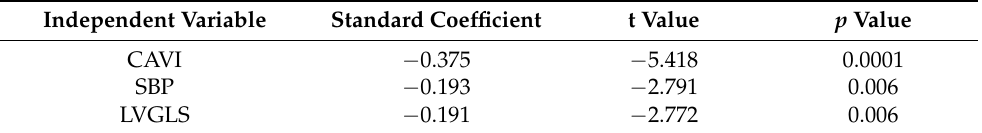
Table 3. Multiple regression documenting the association of LA conduit strain with clinical variables. Independent Variable Standard Coefficient t Value p Value CAVI − 0.375 − 5.418 0.0001 SBP − 0.193 − 2.791 0.006 LVGLS − 0.191 − 2.772 0.006